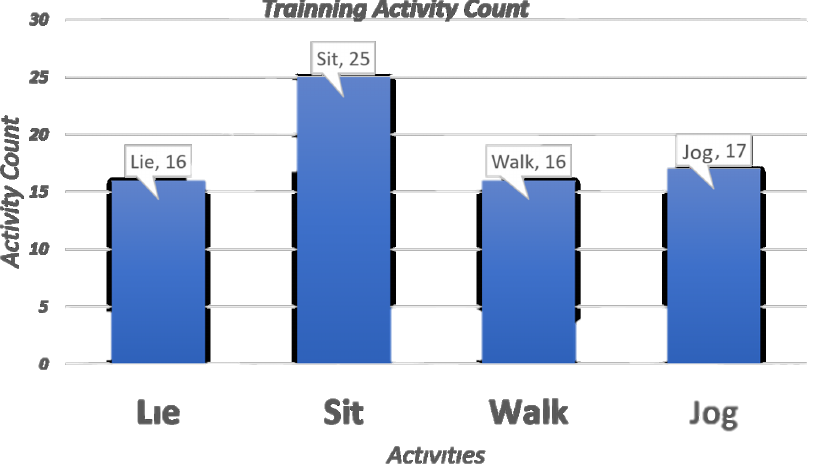
Figure 11. Training data set: activity